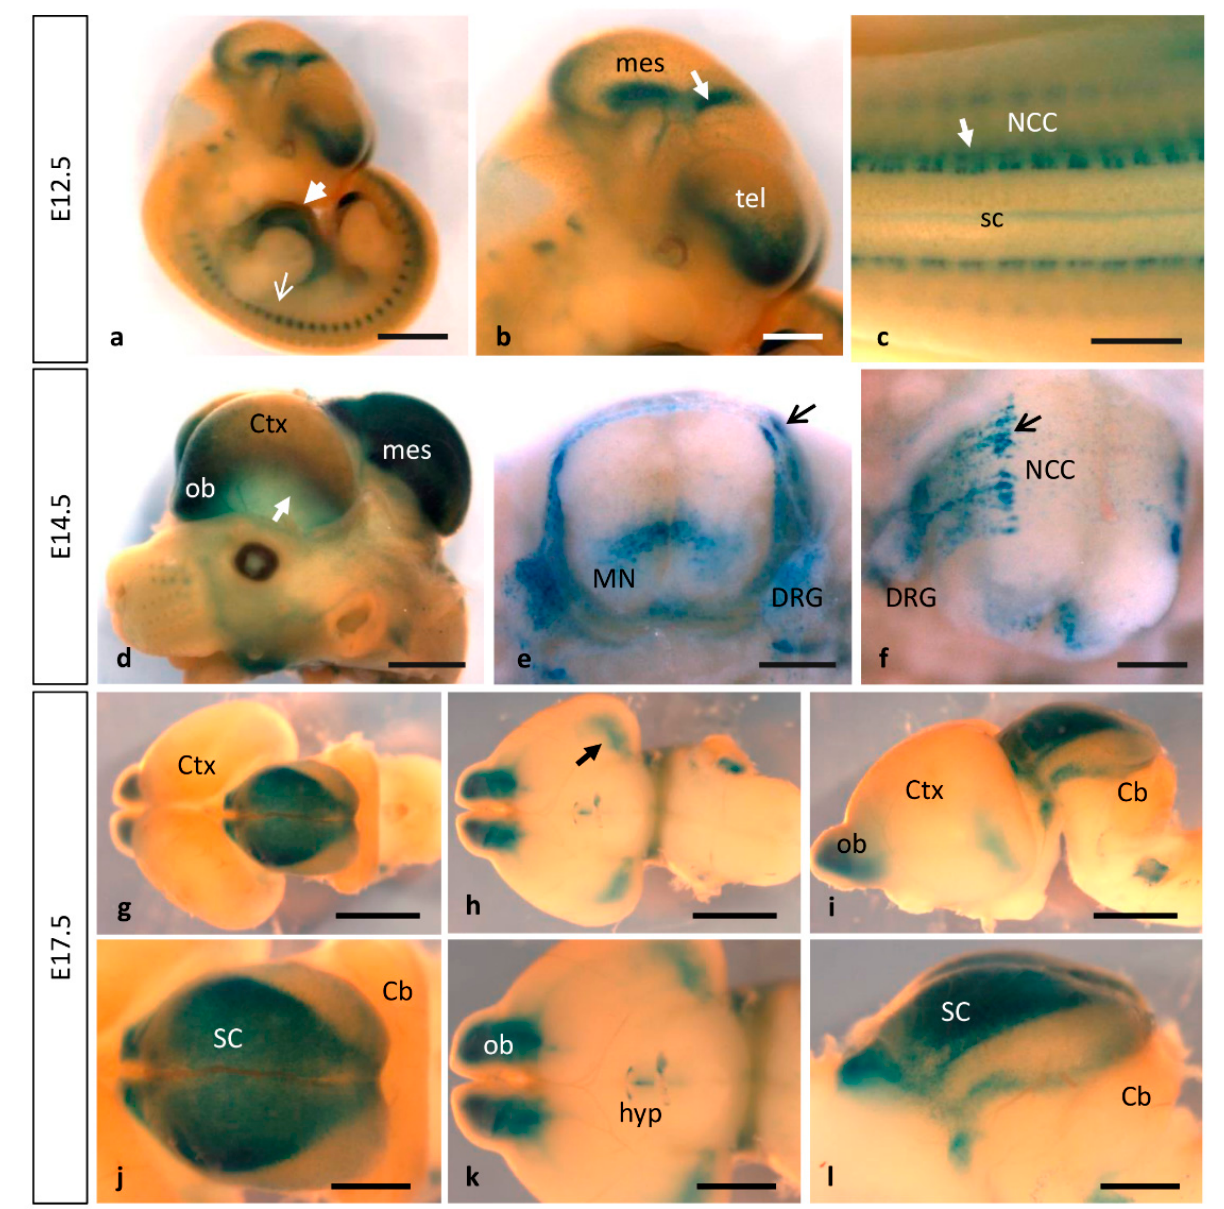
Figure 4. Dynamic expression of MT1-MMP at later stages of brain and embryo development. As development proceeds, stronger pattern of MT1-MMP expression persists in the cardiovascular system and the brain. ( a – c ) E12.5 Mt1-mmp LacZ/+ embryos show reporter expression in the developing heart (white arrowhead in a), somites (white arrow in ( a )) and at distinct regions of the brain: the rostral telencephalon (the prospective olfactory bulb), zona limitans intrathalamica (white arrow in ( b )), the floor plate and the caudal mesencephalon and neural crest cells (white arrow in ( c )). ( d – f ) At E14.5, MT1-MMP expression increases in the olfactory bulb and the caudal cerebral cortex (arrow in a), the dorsal part of the mesencephalon and in neural progenitors and motoneurons of the spinal cord ( e , f ). Further, β -gal positive cells were located in streams of migrating neural crest cells (arrow in ( e , f )), the dorsal nerve root and the dorsal root ganglia. ( g – l ) Later in development, LacZ staining persists in the brain at E17.5: in the olfactory bulb, the amygdala (arrow in ( h , k )), the hypothalamic region and the superior colliculus (( g , j ), dorsal view; ( h , k ) ventral view; ( i , l ), lateral view of the brain). Abbreviations: Cb, cerebellum; Ctx, cerebral cortex; DRG, dorsal root ganglia; hyp, hypothalamic region; mes, mesencephalon; MN, motoneurons; NCC, neural crest cell; ob, olfactory bulb; sc, spinal cord; SC, superior colliculus; tel, telencephalon. Scale bars: 2 mm ( a , d , g – i ), 1 mm ( b , c , j – l ), 500 µ m ( e , f ).